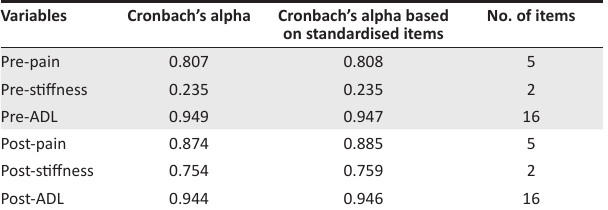
TABLE 2: Cronbach’s alpha scores pre- and post-intervention for Western Ontario and McMaster Universities Osteoarthritis Index.